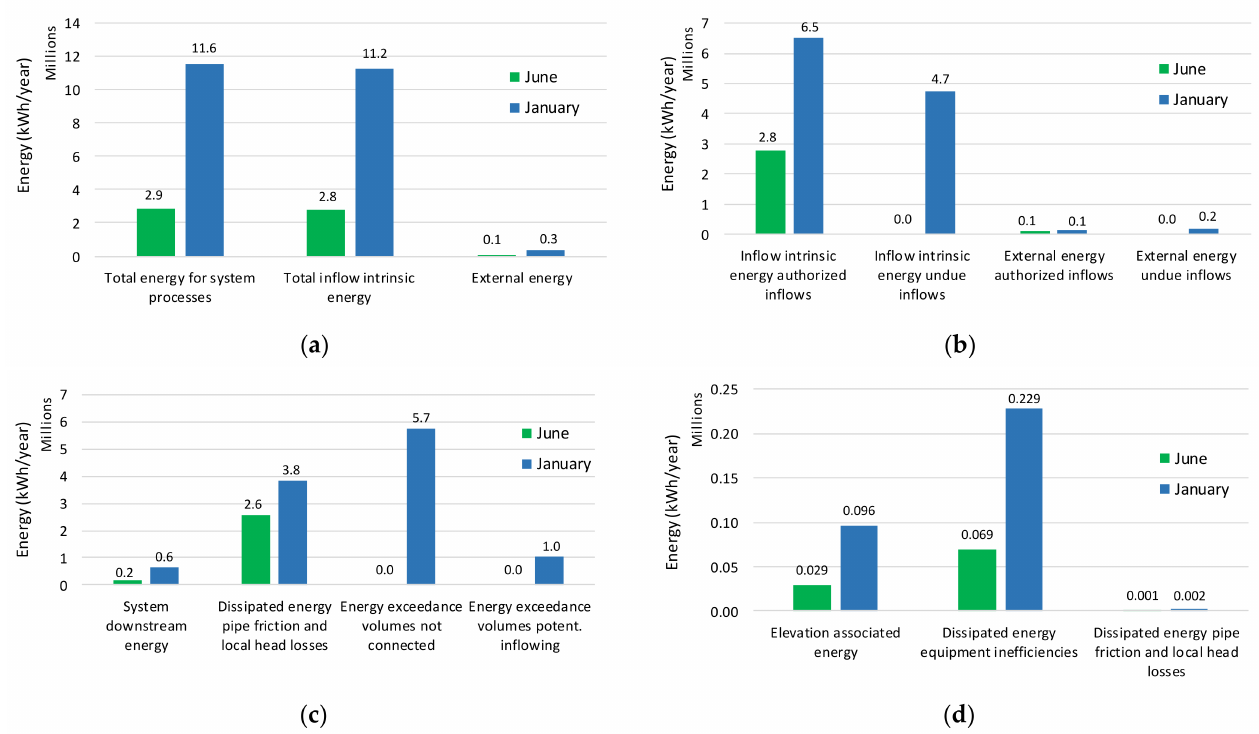
Figure 3. Comparison between the energy balance components for both seasons (June and January): ( a ) Energy inflows: total energy for system processes, total inflow intrinsic energy and external energy; ( b ) energy inflows: inflow intrinsic energy and external energy associated with authorized inflows and to undue inflows; ( c ) energy outflows: system downstream energy, dissipated energy due to pipe friction, and local head losses and exceedance volumes not connected to an energy consuming component and potentially inflowing to an energy-consuming component; ( d ) energy outflows: elevation associated energy and dissipated